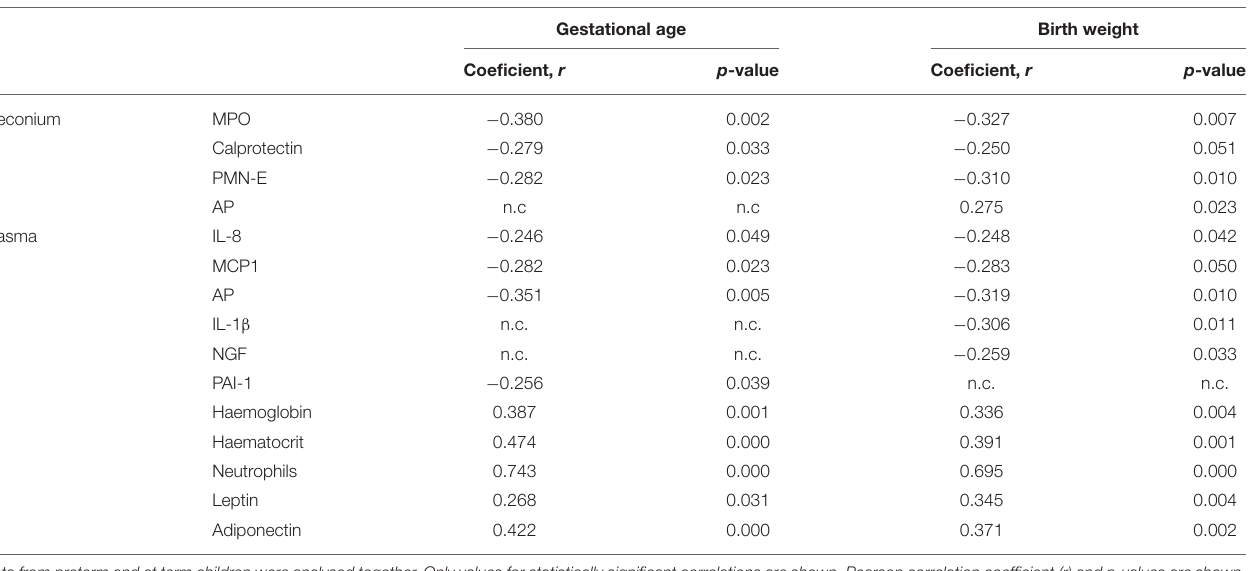
TABLE 1 | Correlations of gestational age and birth weight with meconium and plasma parameters.